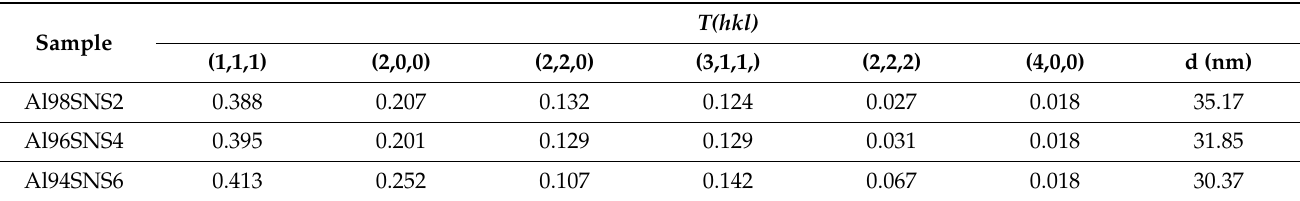
Table 4. Texture coefficient T(hkl) and crystallite size d (calculated after (111)